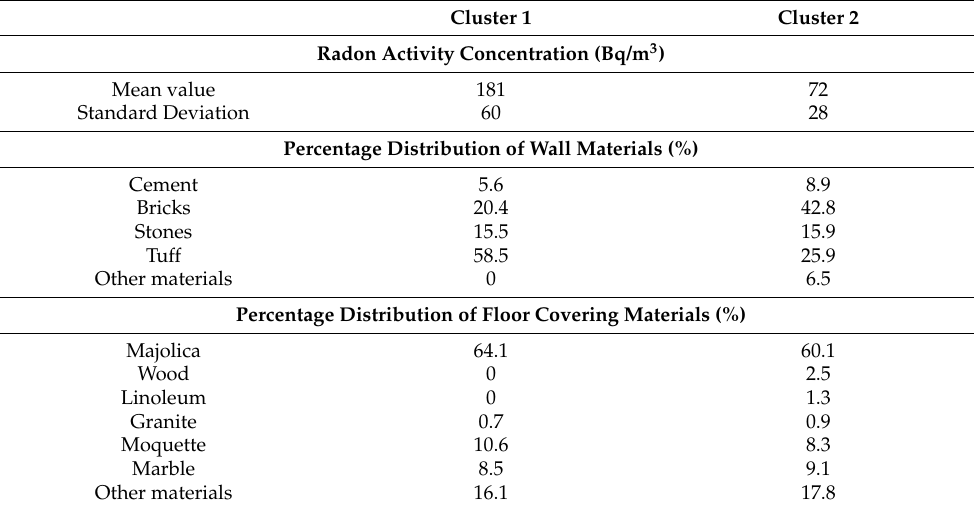
Table 2. Characteristics of the two clusters identified with the latest k-means